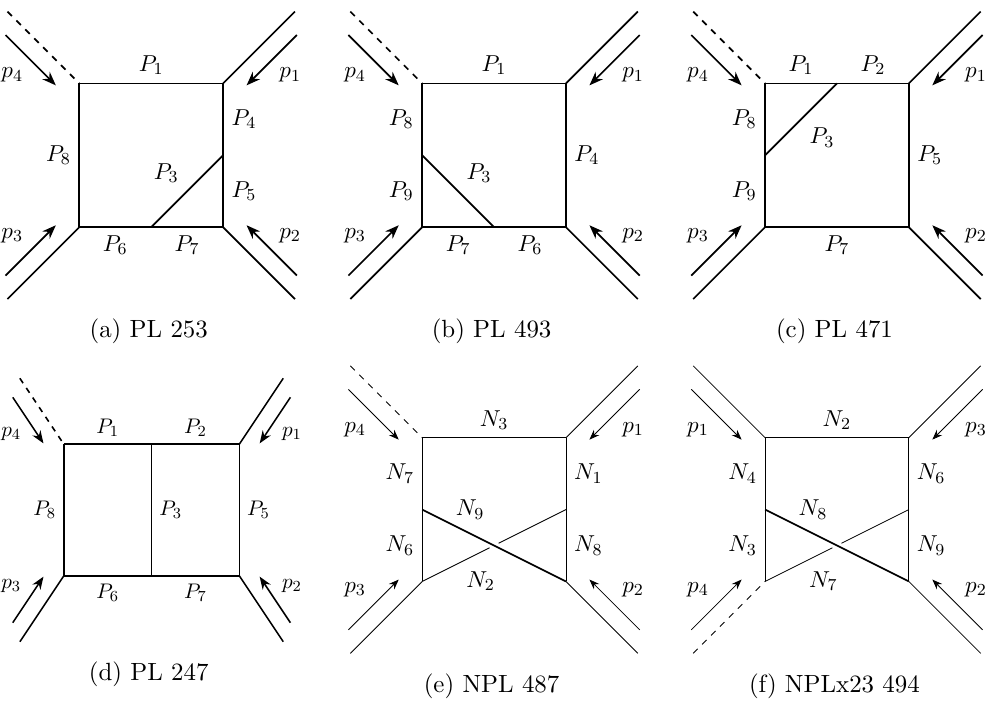
Figure 1. The 4 planar and 2 non-planar sectors with t = 7 , labelled with the propagators P i and N i , respectively, as listed in table 1. Their names indicate the integral family and sector ID. The sectors (d)-(f) contain new master integrals and are the focus of this section. Sectors (a) and (b) are entirely reducible to master integrals found in the trees of the former three top sectors. Sector (c) can be reduced to masters from (d)-(f) and four additional integrals which are easily computed from one-loop